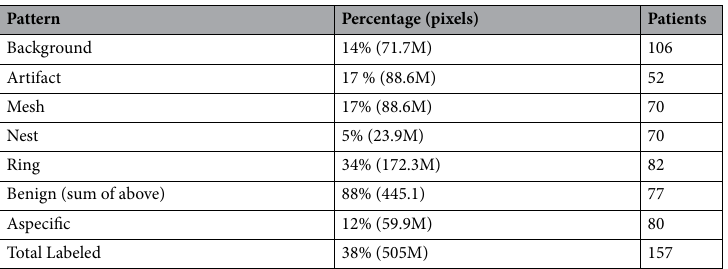
Table 1. Class distribution statistics: the top section of the table reports the distribution of labels. In the bottom section, we report the overall fraction of pixels that were labeled as well as the number of mosaics that were used in the study. Each mosaic was collected from a different